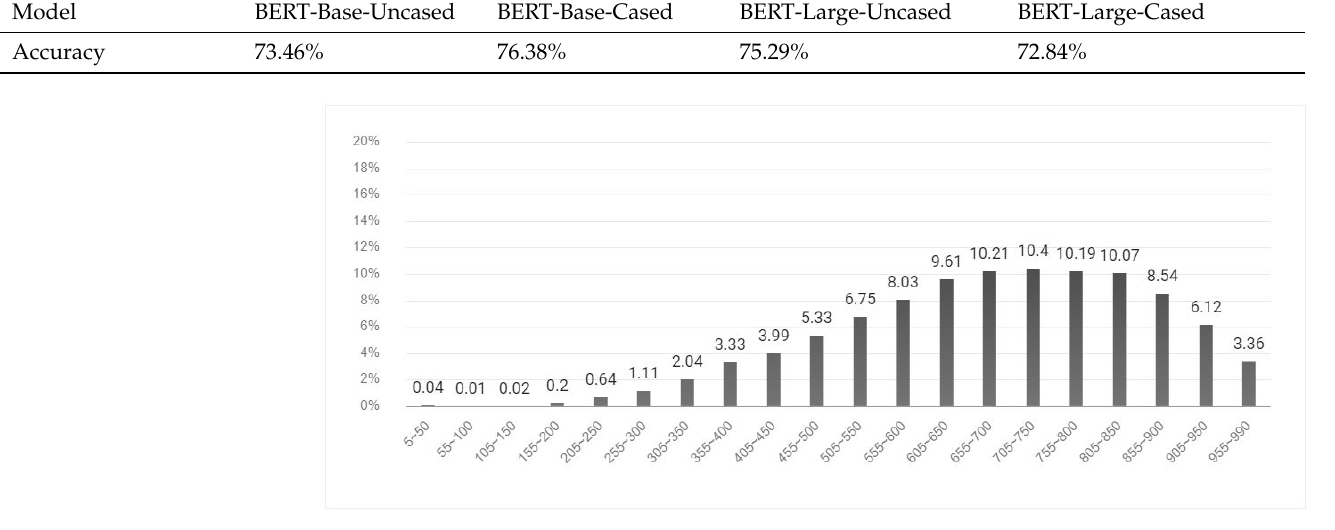
Figure 1. Distribution of the number of people by the score for the 455th test (implemented on 20 February